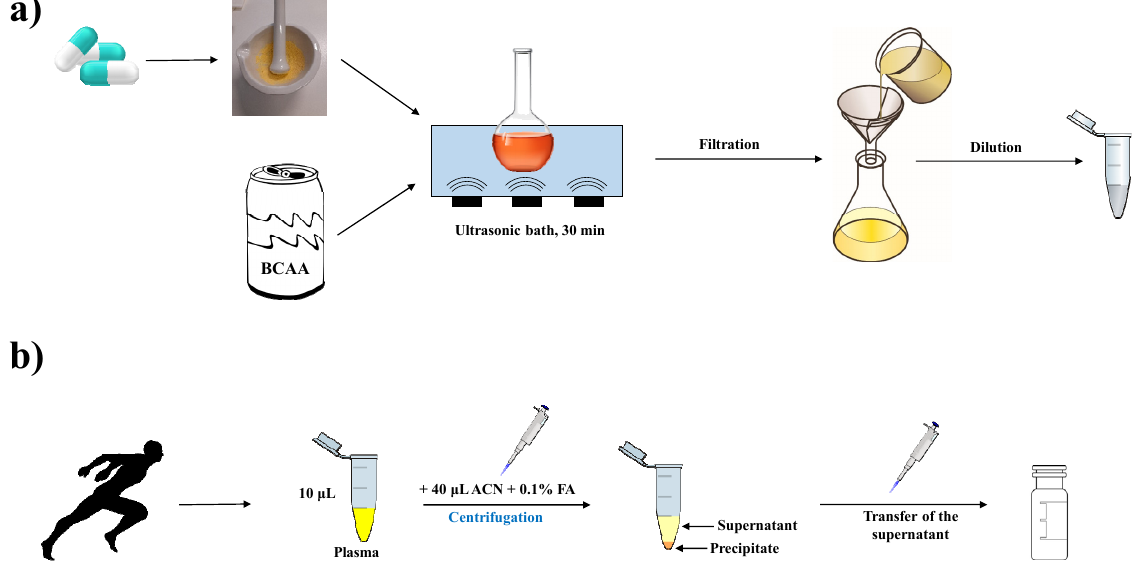
Figure 6. Sample preparation workflow—( a ) preparation of food and sports nutritional supplements, ( b ) preparation of human plasma samples.